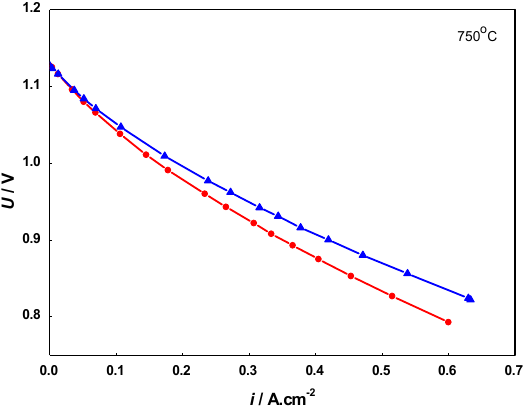
Figure 9. Current-voltage ( i-V ) curves of: artificially aged cell before redox cycling ( ▲ ) and after 20 redox cycles ( • ).